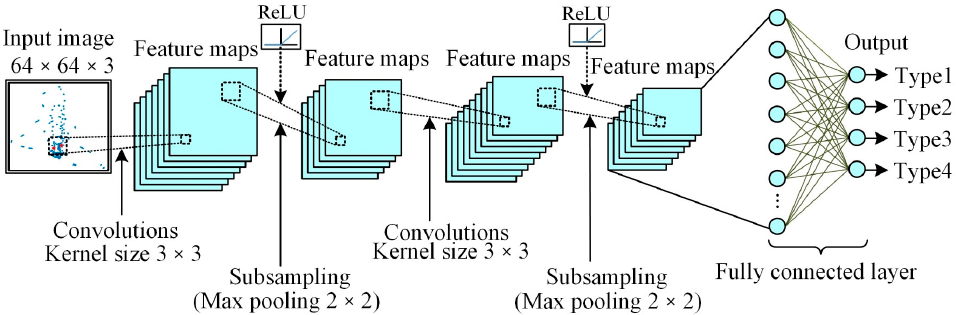
Figure 11. The designed CNN model architecture.